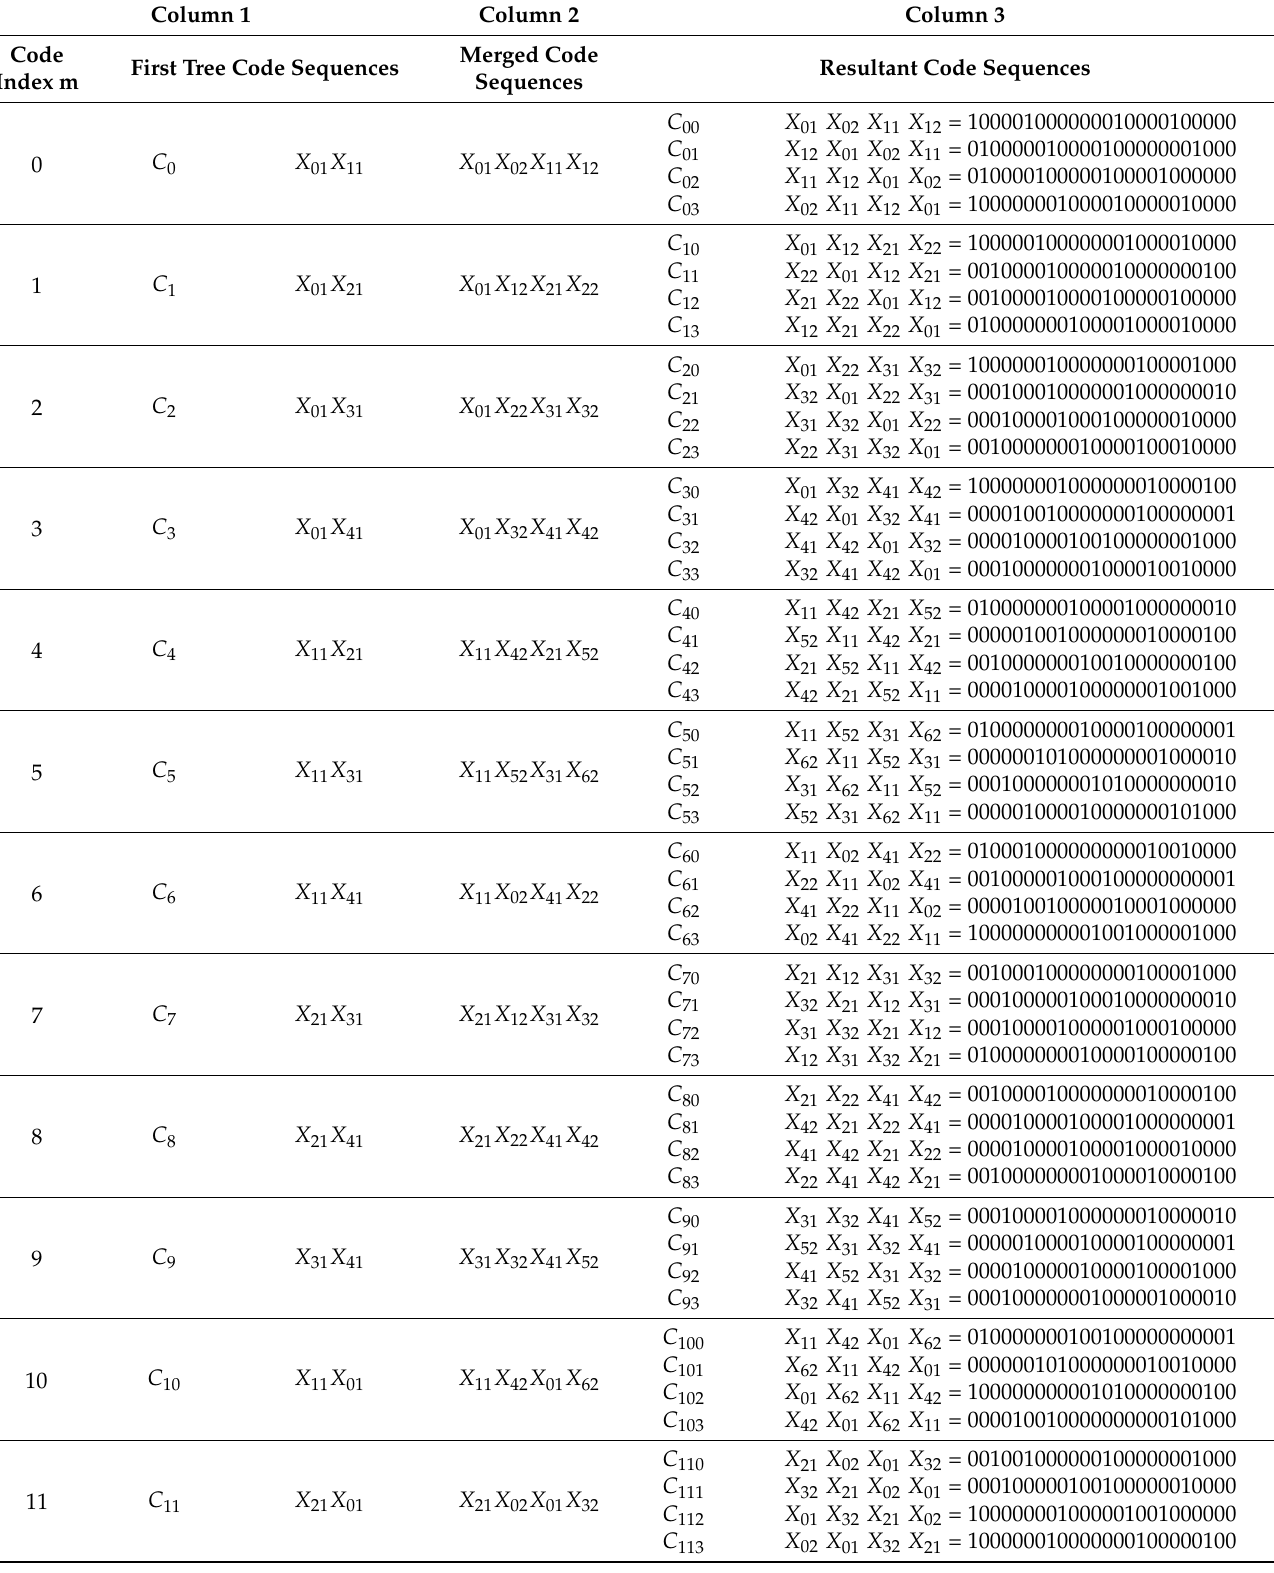
Table 3. HPC sequences for P 1 = 5 and P 2 =